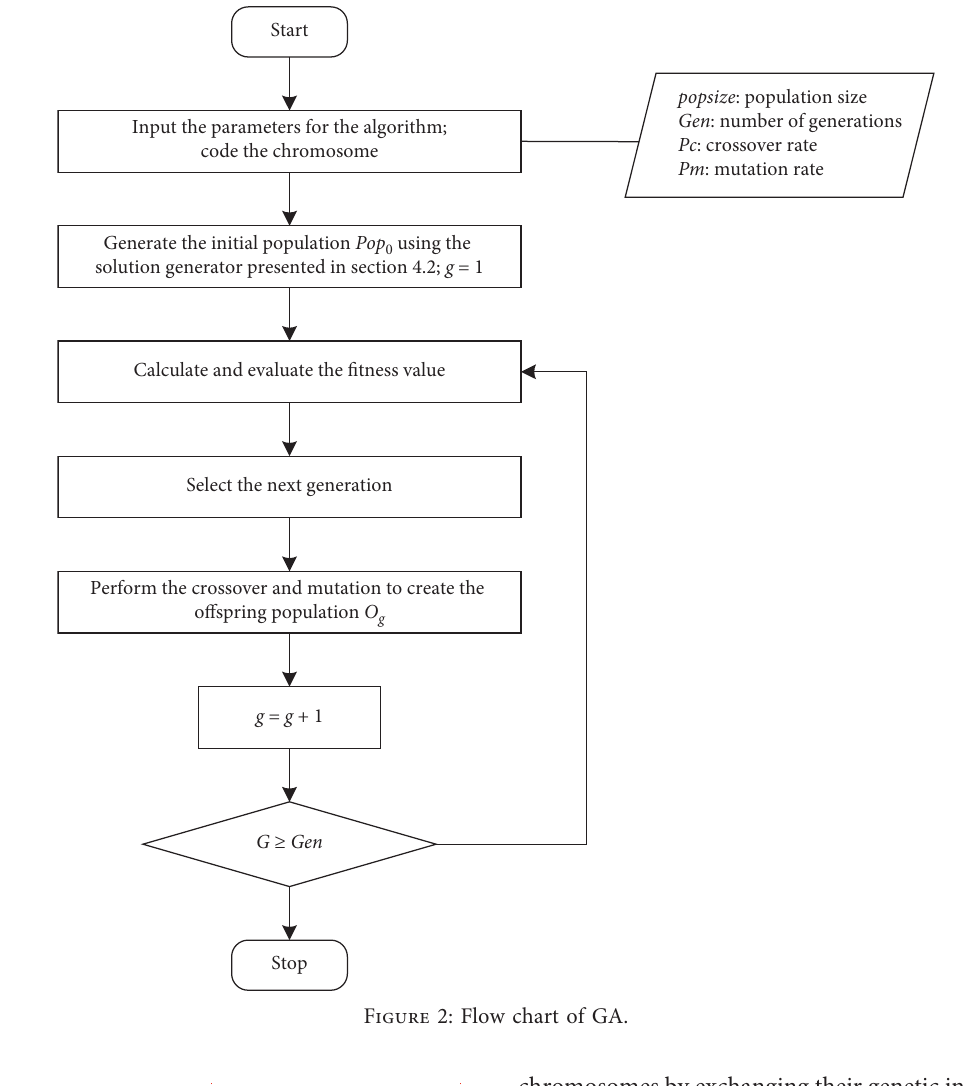
Figure 2: Flow chart of GA.